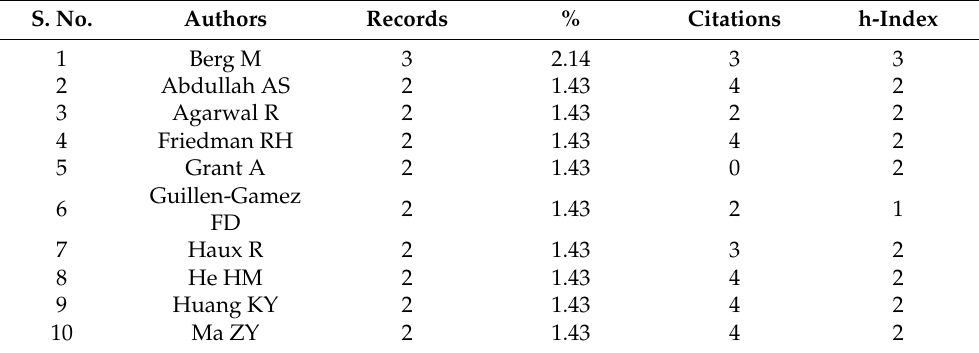
Table 2. The contribution and influence of highly productive authors in health sciences research. S.